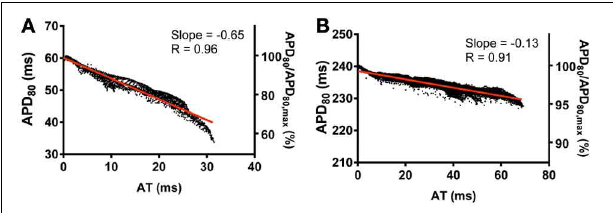
FIGURE 12 | Correlations between AT and APD in the transmural plane of rat (A) and pig (B) myocardium. AT and APD 80 plots corresponding to the horizontal transmural plane at the level of the pacing site in simulations from Figure 2 . Slopes for linear correlation analyses are indicated. Secondary y -axes show APD 80 expressed as a percentage of maximum APD 80